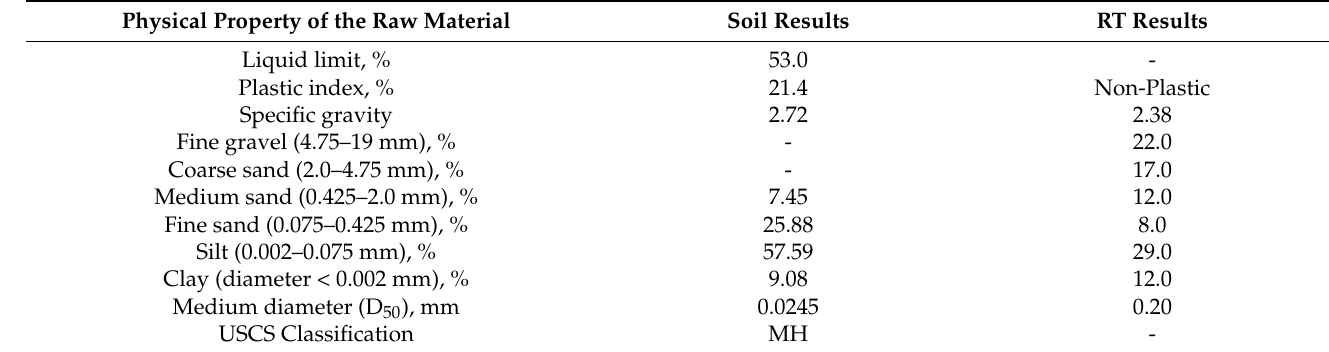
Table 1. Physical properties, RT waste, and the sedimentary silty soil samples.